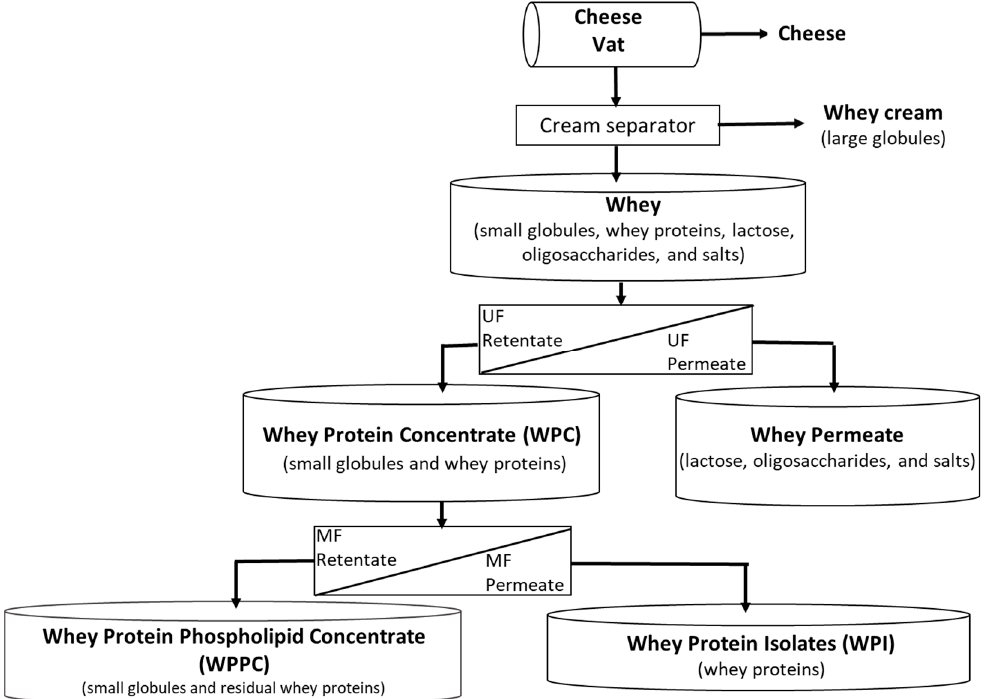
Figure 1. Manufacture of whey protein concentrate and isolate, which results in the accumulation of whey protein phospholipid concentrate (WPPC). Figure adapted from [40].